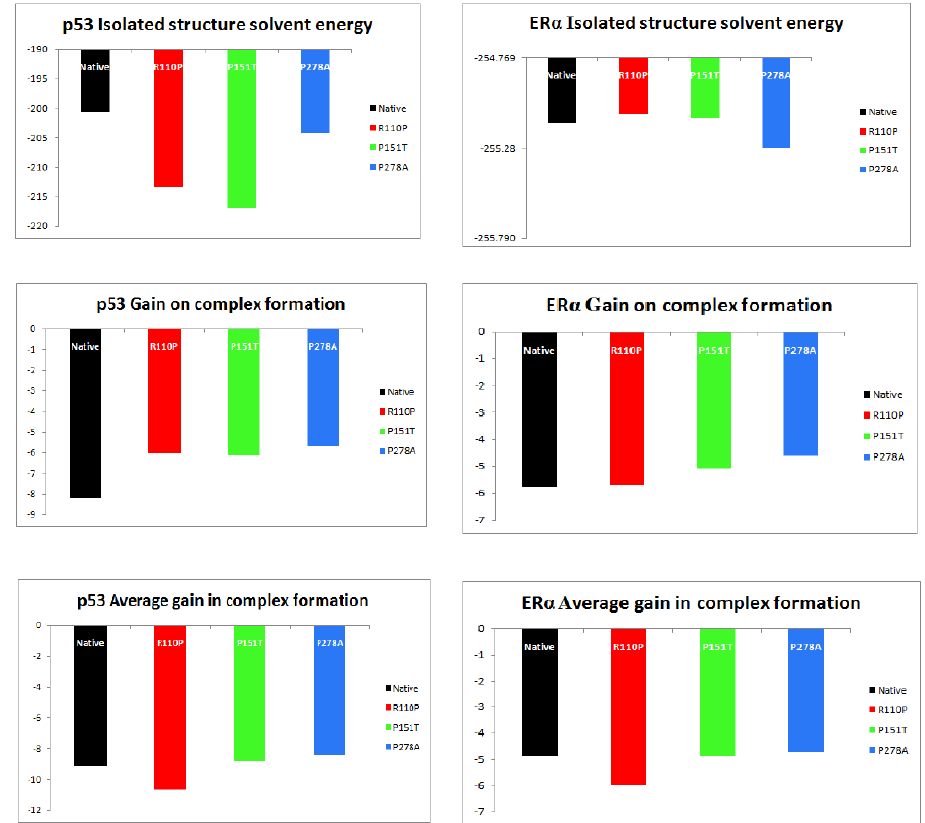
Figure 5. Analysis of the isolated solvent energy and gain in complex formation in p53- ERα complexes. Black: native or WT, Red: R110P, Green: P151T, Blue: P278A. Black: native or WT, Red: R110P, Green: P151T, Blue: